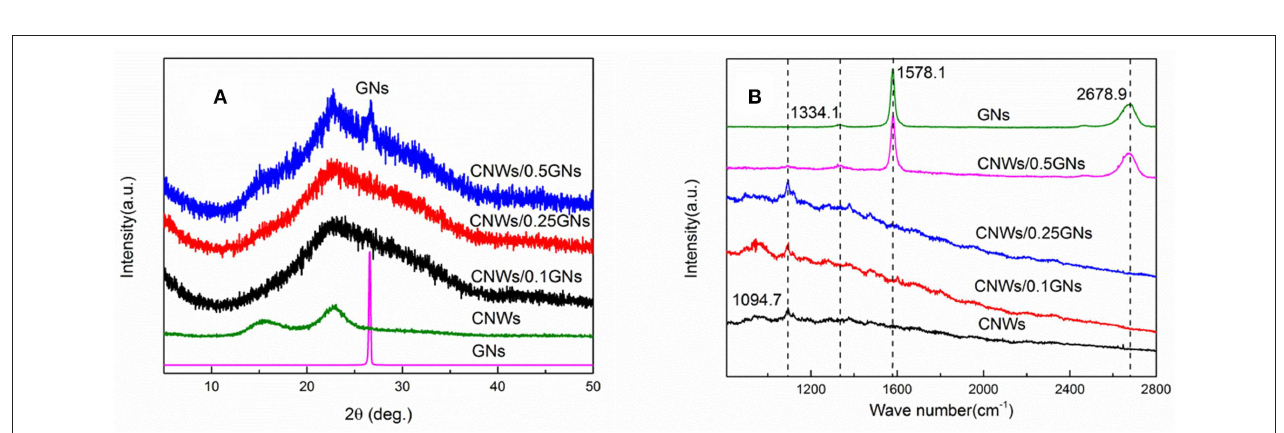
FIGURE 6 | Structural analysis of CNW films and CNW/GN composite films: (A) XRD patterns and (B) Raman spectra.